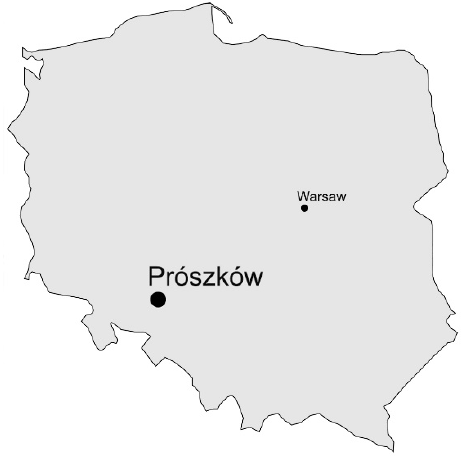
Figure 1. Poland and the location of Prószków, created by authors.